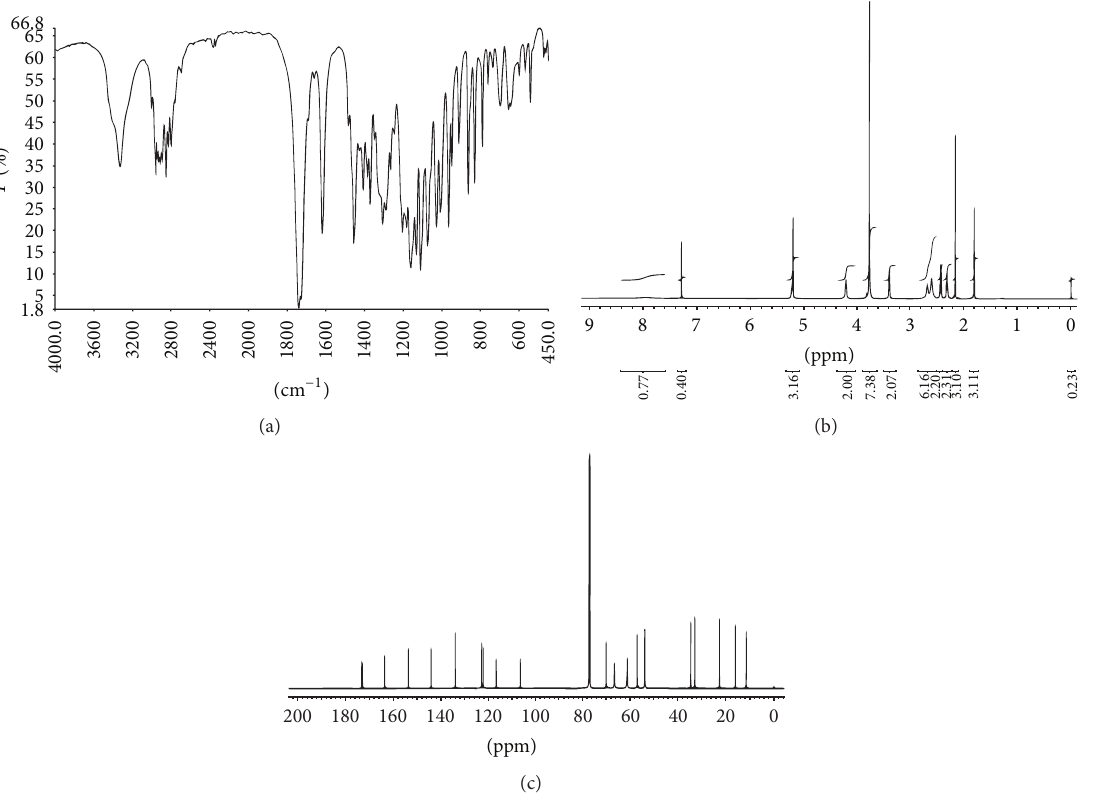
Figure 2: Identification of MMF by IR (a), 1 H-NMR (b), and 13 C-NMR spectrum (c).